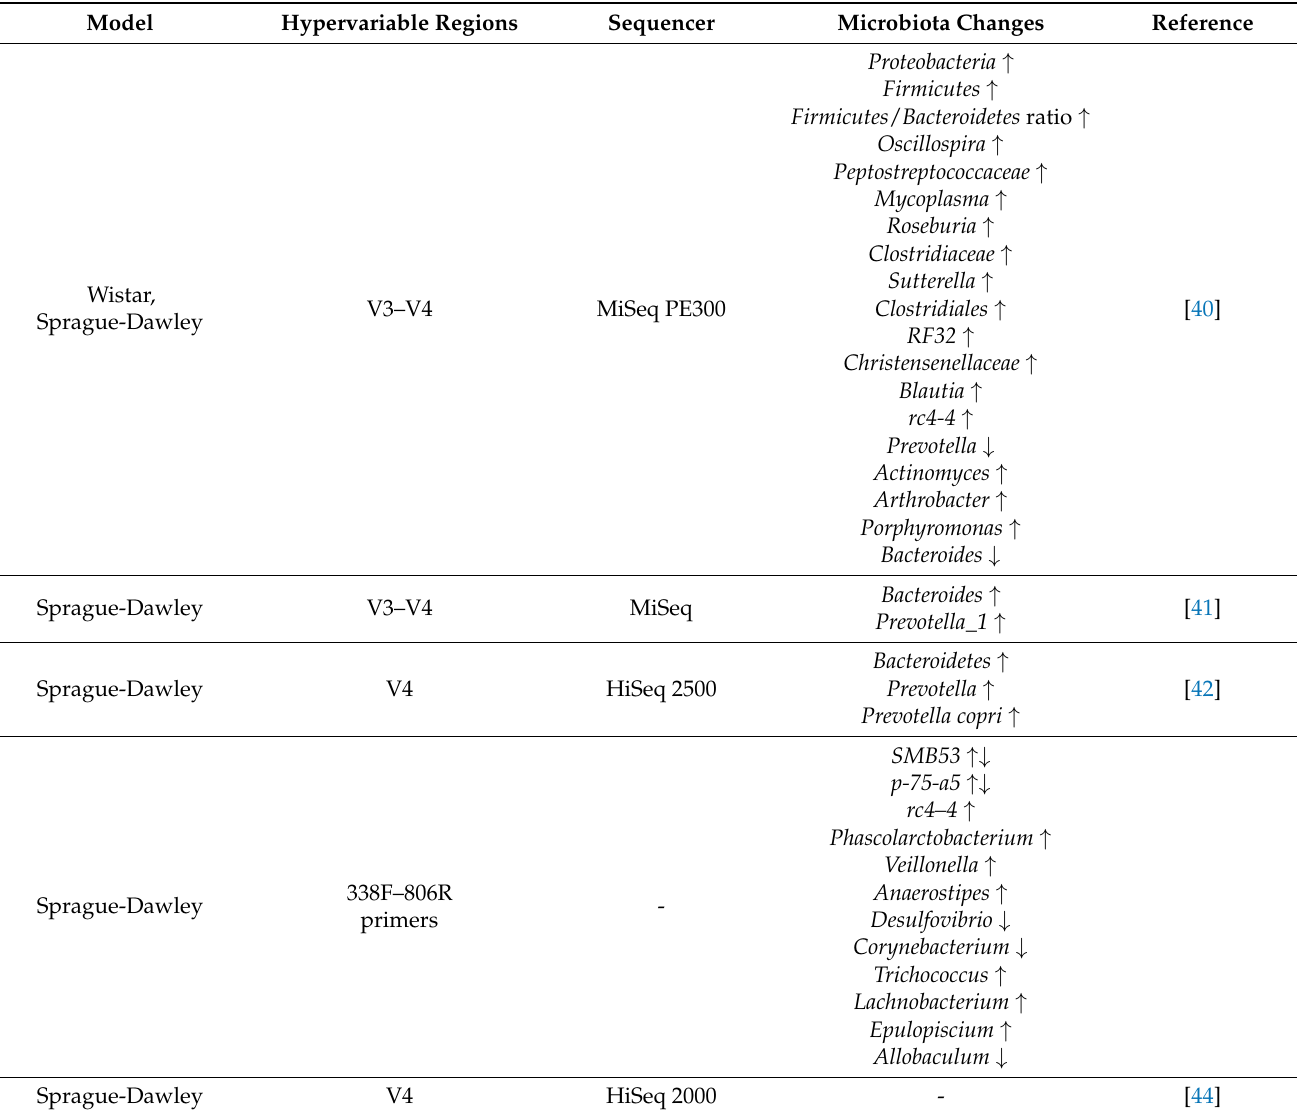
Table 3. Summarization of the studies in which the authors sequenced the 16S rRNA in